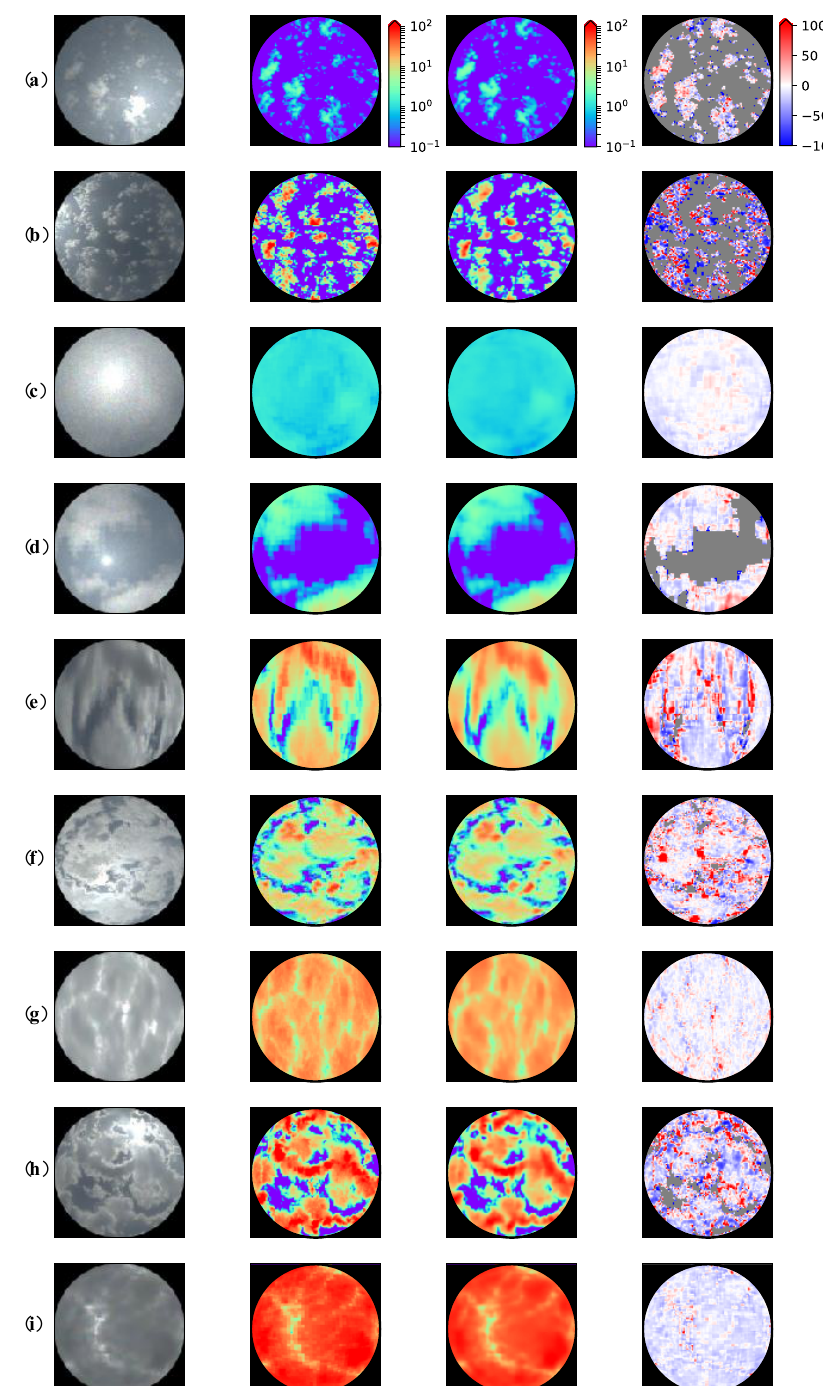
Figure 10. Examples of SCOT estimated by the CNN for cases ( a–i ) in the test dataset. The leftmost column shows the true-color images, the two middle columns show the (left) ground-truth and (right) estimated SCOT, and the rightmost column shows the relative error (%) of the estimated SCOT.